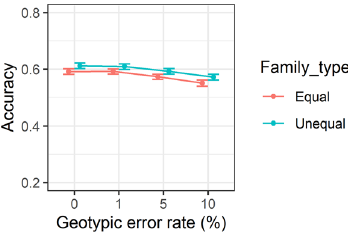
Figure 5. Accuracy of genomic estimated breeding values over genotypic error rates of 0, 1, 5 and 10% for equal versus unequal family contribution. Correlations are averaged over different generations, replicates, SNP densities and heritability. Standard errors of accuracies are shown as error bars.